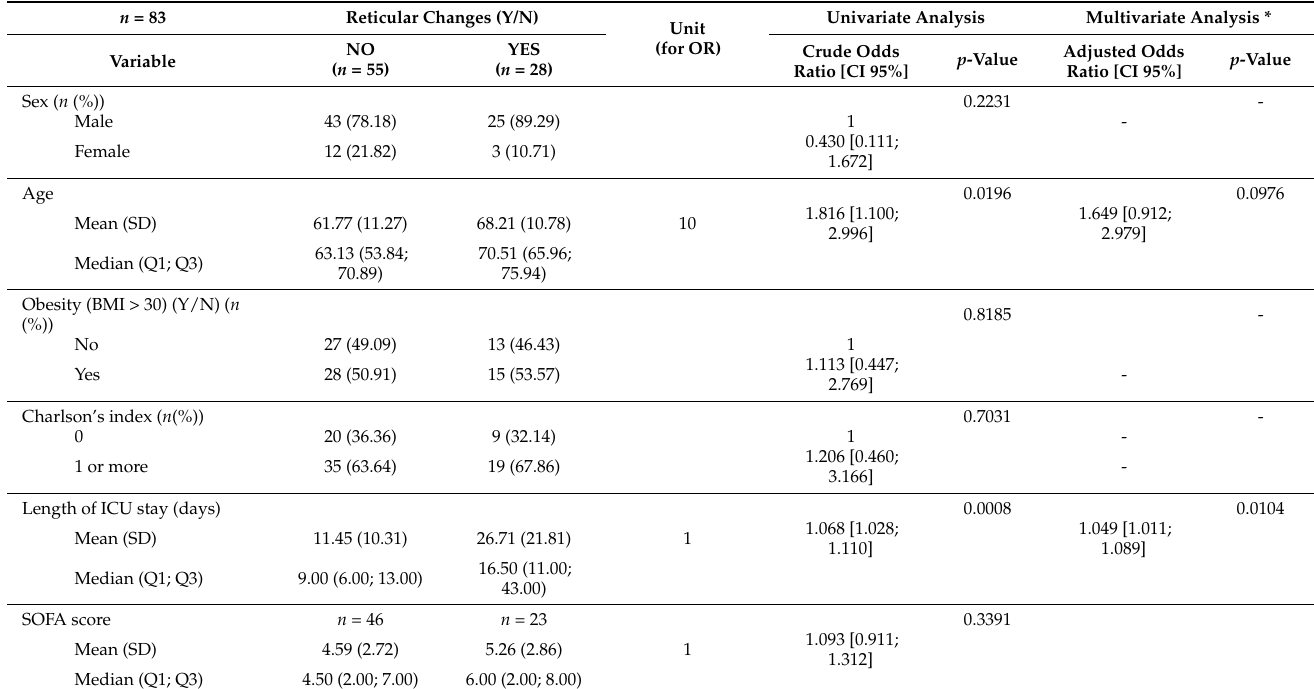
Table 4. Factors associated with reticular changes including